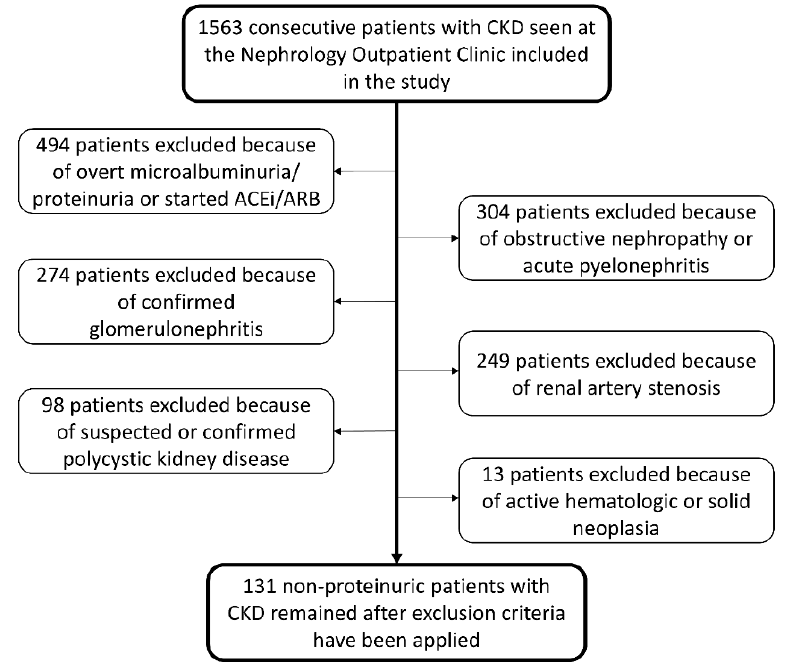
Figure 1. Flowchart of patients’ selection.